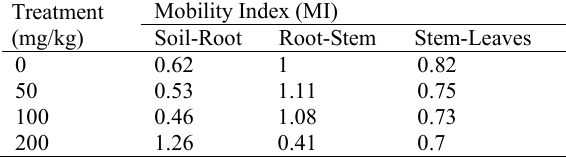
Table 2. Ni Mobility Index in Sunflower